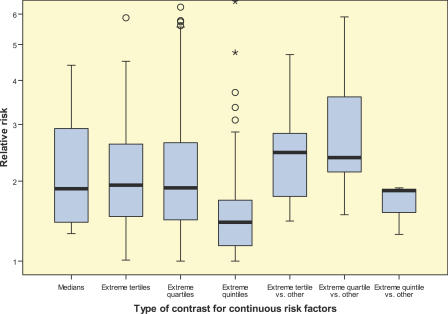
Box Plots for Relative Risks for Different Contrasts of the Values of the Postulated Risk FactorAll relative risks have been coined to be ≥1.00 for consistency.